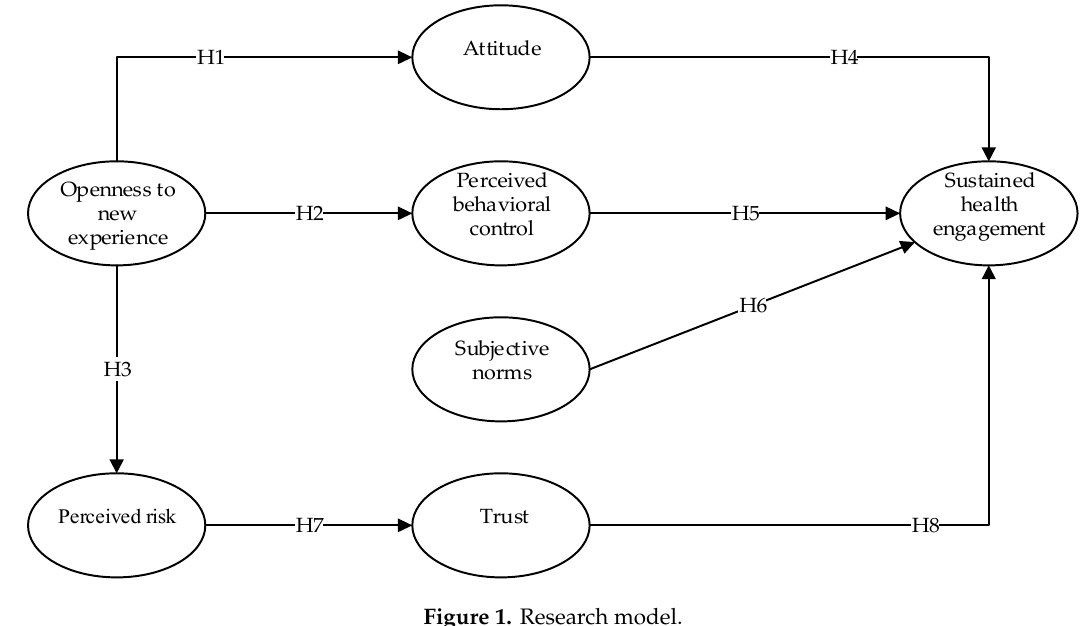
Figure 1. Research model.